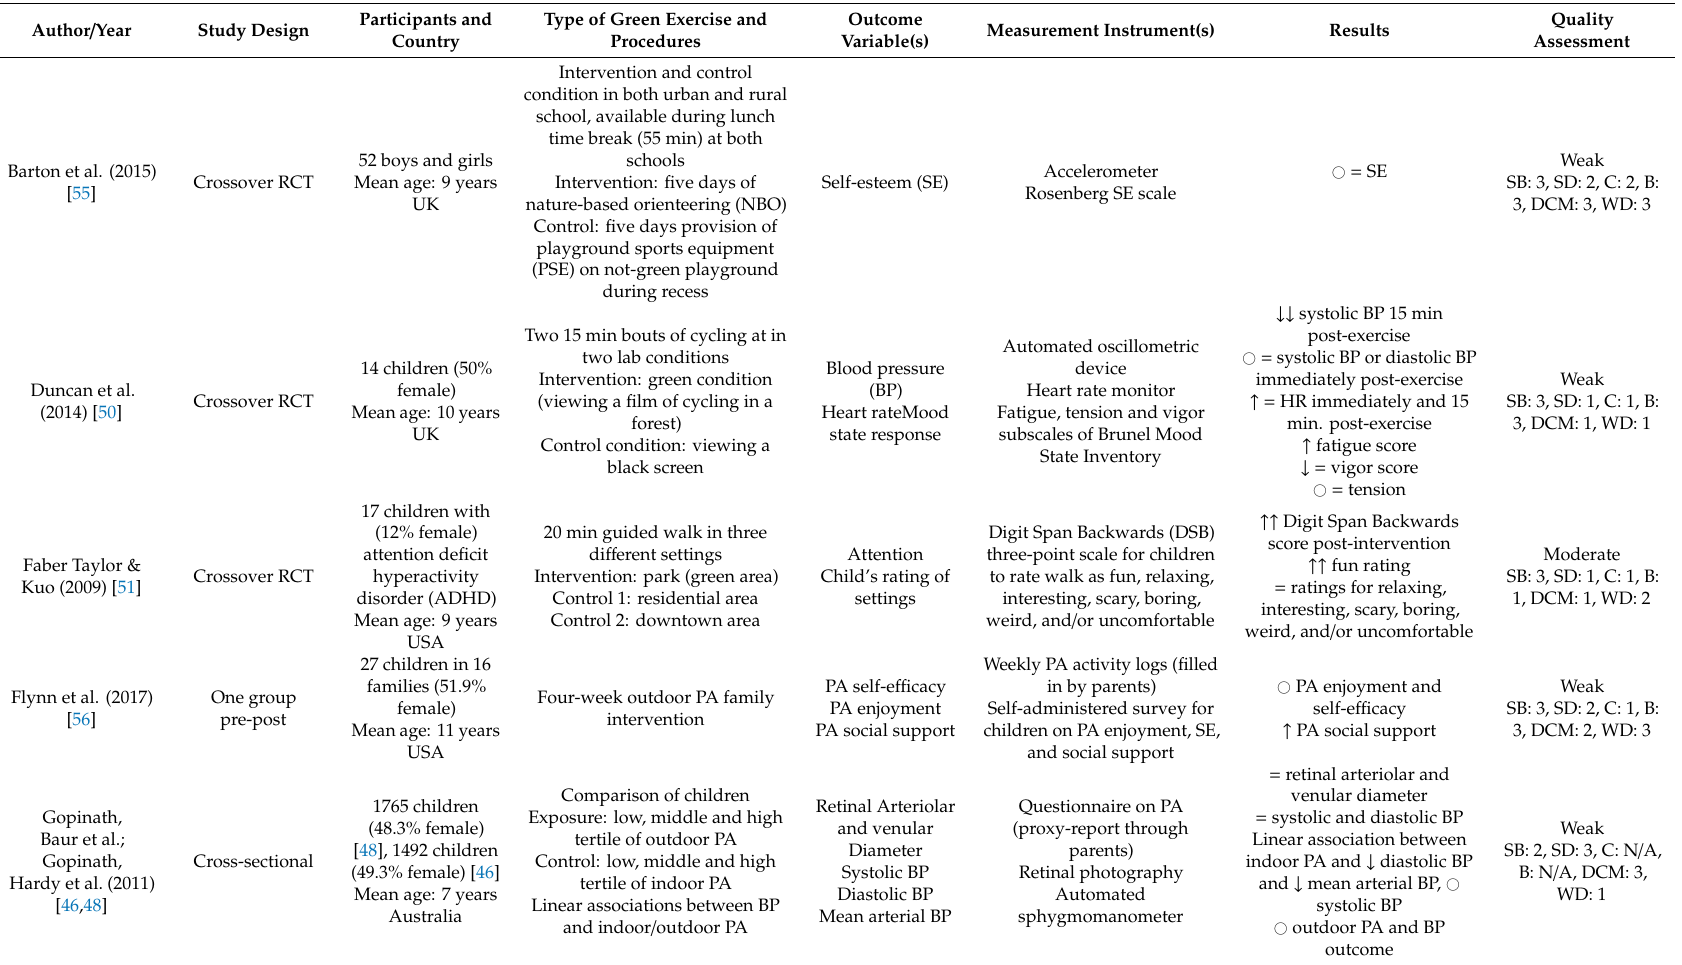
Table 2. Characteristics of the included